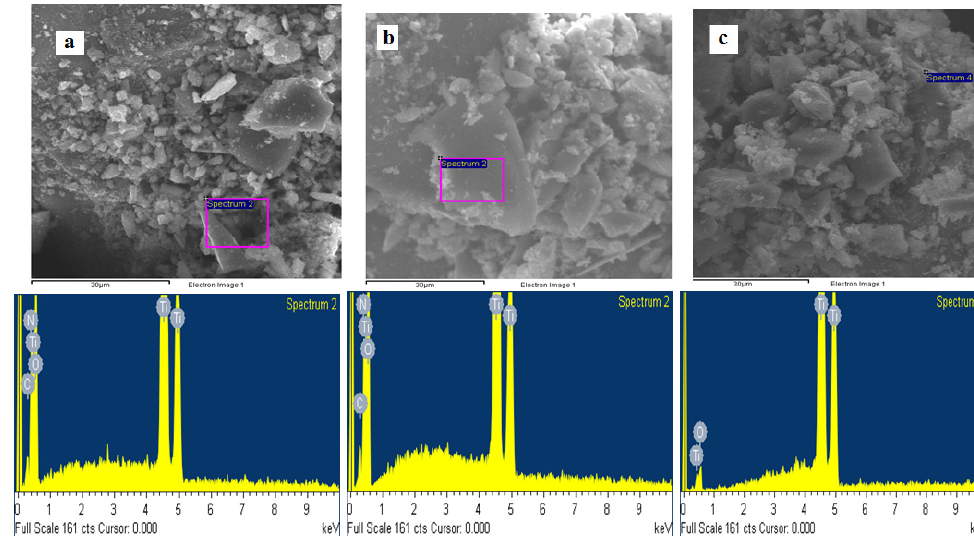
Fig. 7. SEM images and EDX patterns of a) 20 Eth 300, b) 20 Eth 400 and c) 20 Eth 500